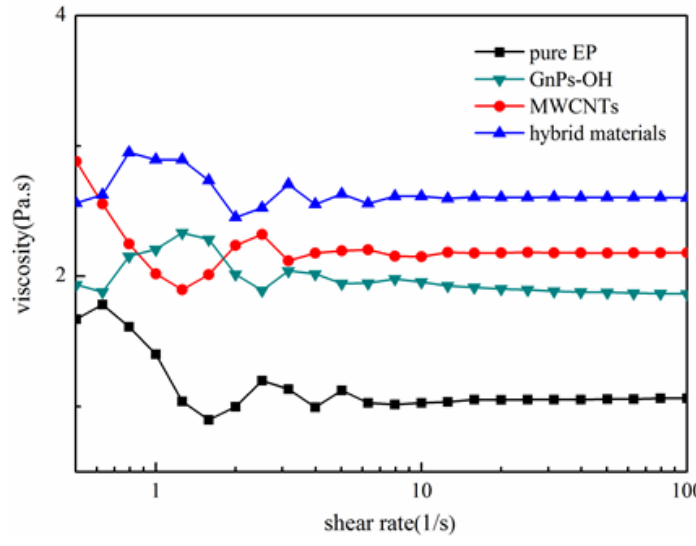
Figure 5 . The viscosity vs. shear rate of epoxy and epoxy composites.